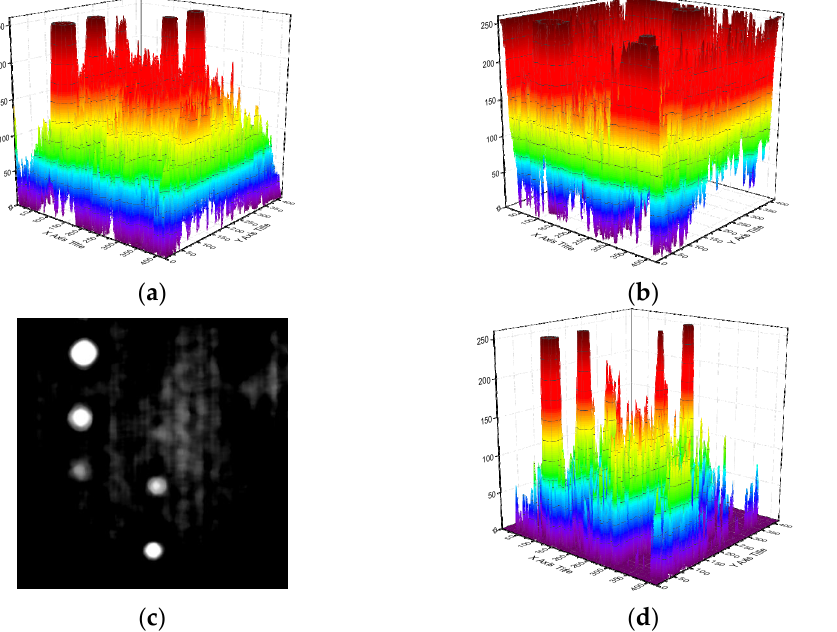
Figure 8. Detection enhancement of FDTI on voids in silicone rubber. ( a ) SNR of 10th frame 1st DTI. ( b ) SNR of 275th frame 1st DTI. ( c ) FDTI from subtracting 1st DTIs. ( d ) SNR of FDTI.